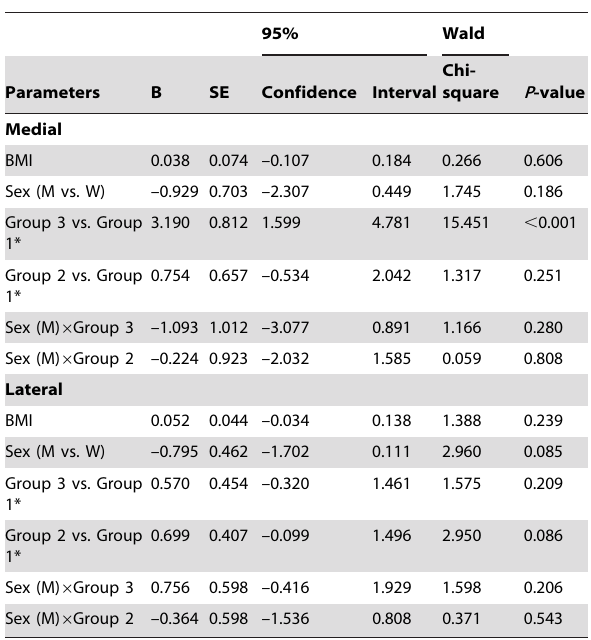
Table 5. Comparisons of T2 values of medial/lateral menisci among three age groups and two gender groups after adjusting for the BMI effect in multiple linear regression analysis.